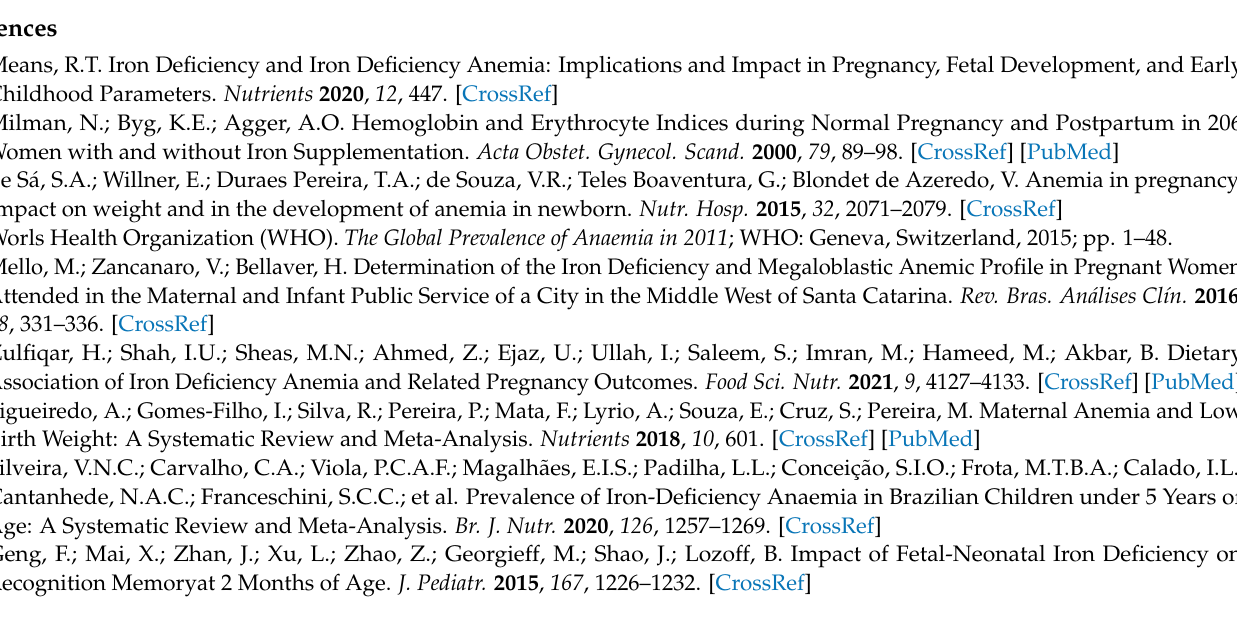
Table S2: Risk of bias for each individual study JBI critical appraisal checklist for prevalence studies. Table S3: Prisma Checklist. Table S4: Excluded Articles and Reasons for